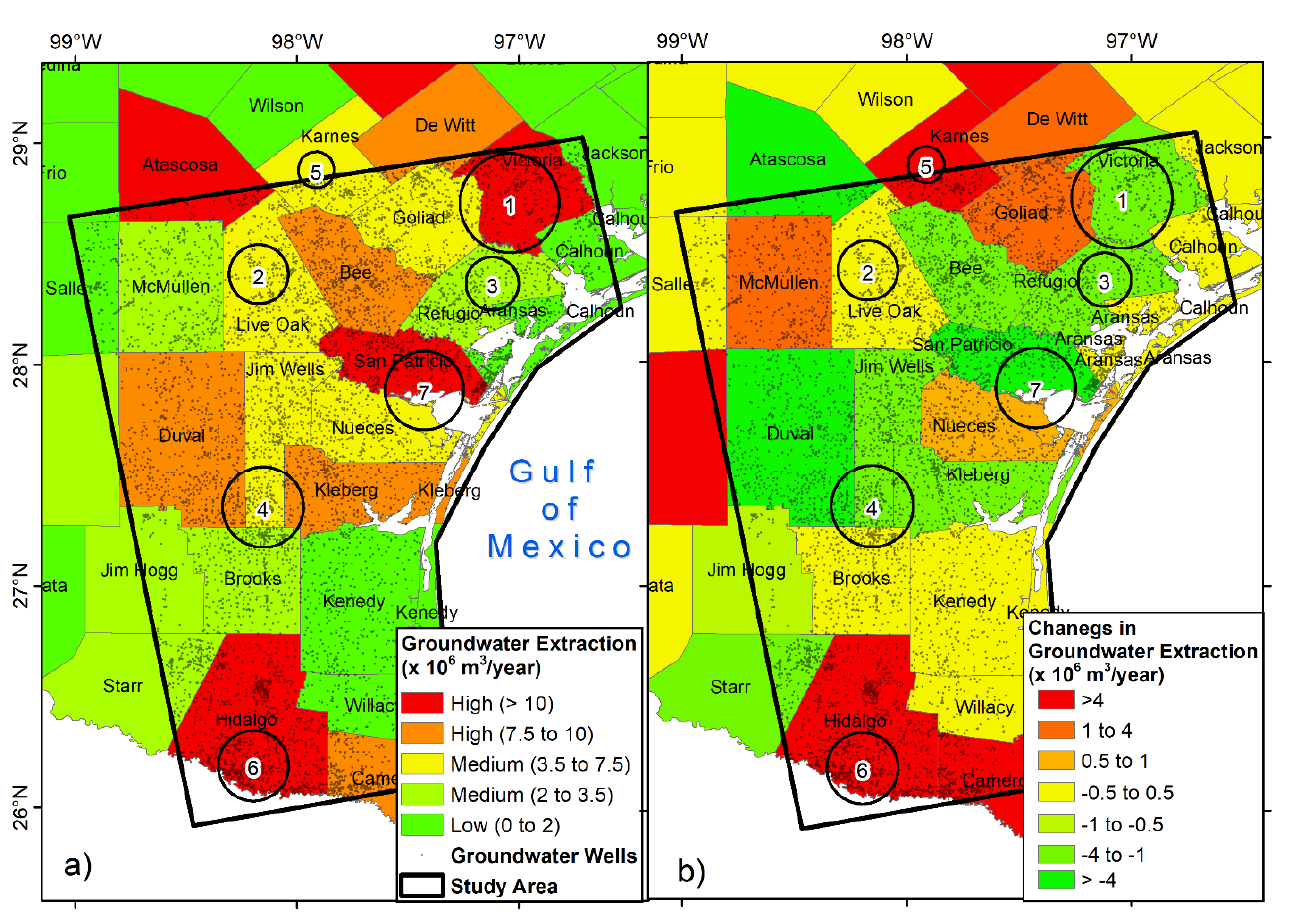
Figure 3. ( a ) Historical groundwater extraction averaged by county during the period from 2000 to 2015. Groundwater well locations are represented by black translucent dots. ( b ) Difference in groundwater extraction rates between the study period (2016–2019) and the historical period (2000–2015).